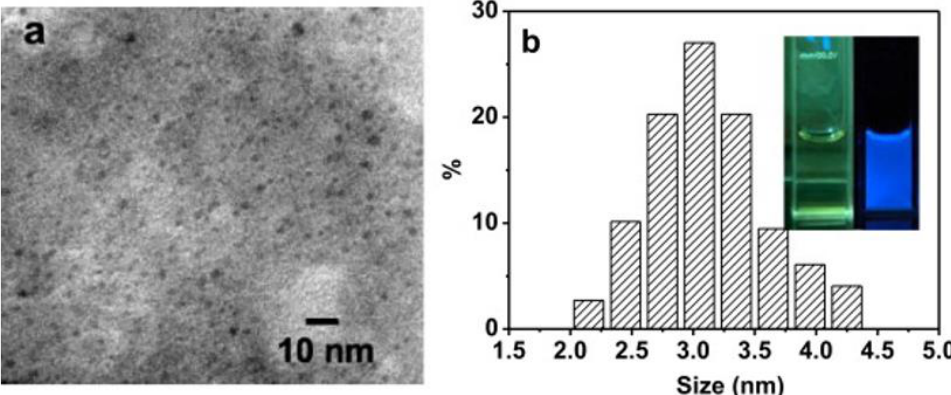
Figure 1. ( a ) TEM image of plant soot-derived CDs; ( b ) size distribution of the CDs determined by measuring 150 CDs via TEM. Reproduced with authorization from [14] .